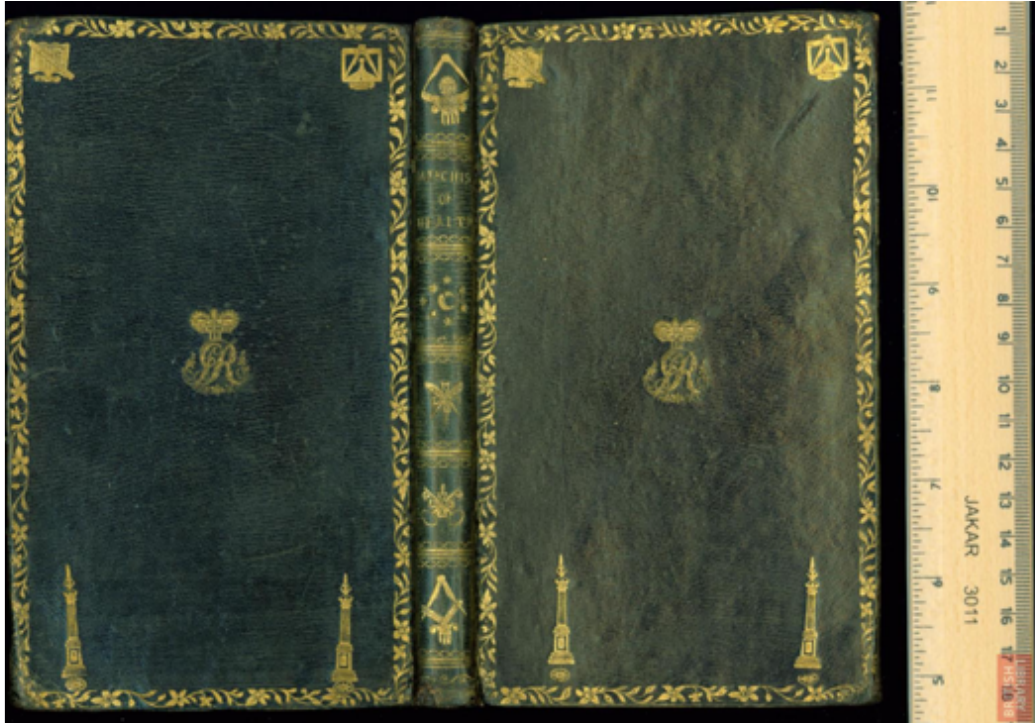
Fig. 35. Bernhard Christoph Faust, [ Der Gesundheits-Katechismus .] Catechism of Health (London, 1794). Note the irregular placement of two of the column/candlestick tools. BL,